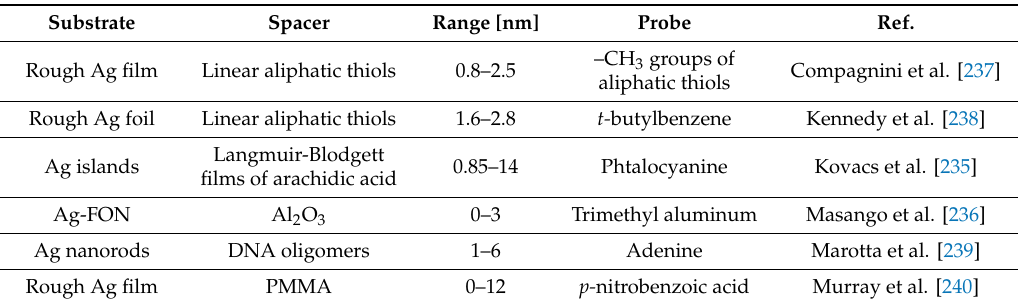
Figure 15. SERS signal as a function of the distance from the surface. A short and a long-range component are identified; they are associated to morphological features of the metallic substrate with a size of approximately 1 nm and 20 nm, respectively. In the insets, a scanning electron microscopy (SEM) picture of the SERS substrate (silver film over nanospheres) and a simulation of the electric field are presented. Reproduced with permission from Masango et al. [236]. Copyright (2016), American Chemical Society. Table 3. Summary of experimental studies investigating the distance dependence of the SERS enhancement / signal. Abbreviations. Ag-FON: Ag film over nanosphere; DNA: Deoxyribonucleic acid; PMMA: poly(methyl